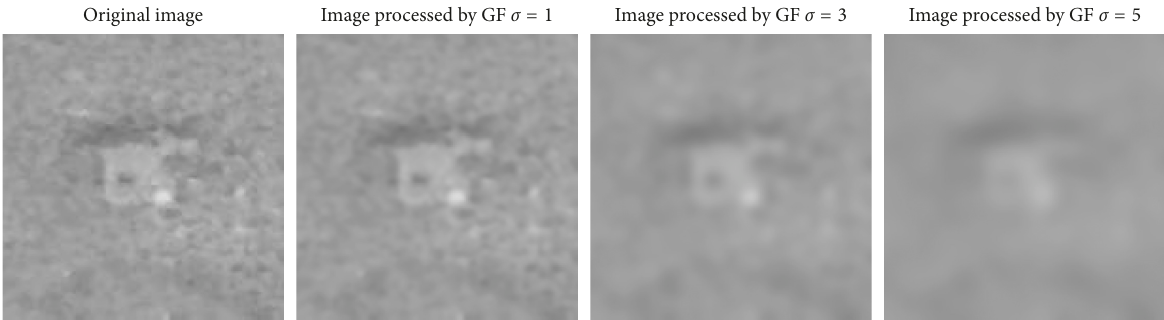
Figure 1: Image smoothing with the Gaussian